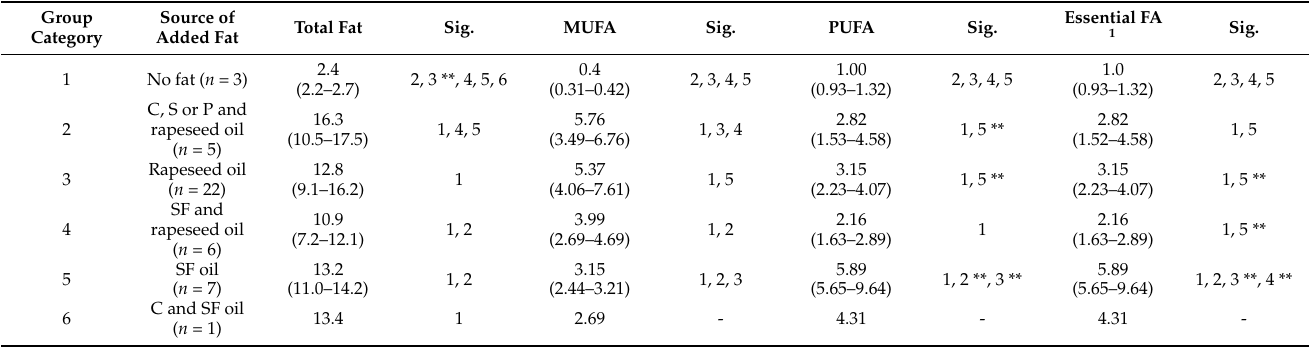
Table 3. Content of total fat, monounsaturated fatty acids (MUFA), polyunsaturated fatty acids (PUFA) and essential fatty acids (FA) in the analyzed meat substitutes, separated and analyzed according to the added